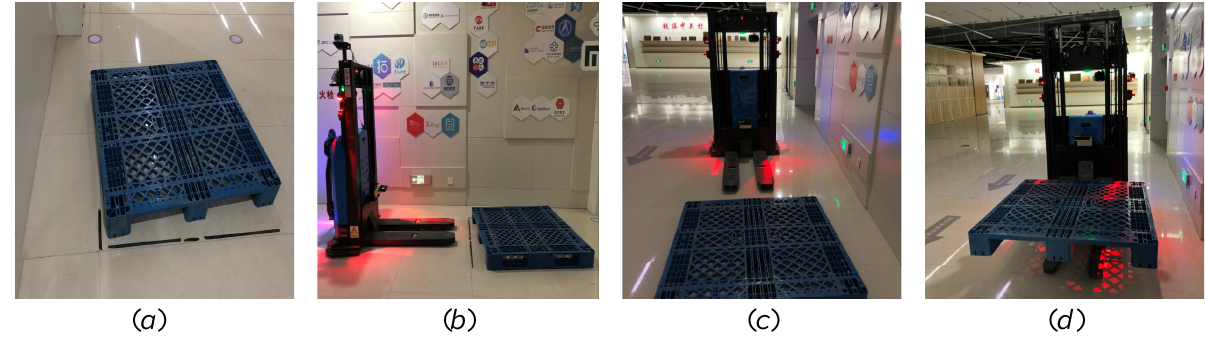
Figure 16. Difficult scene present near the pallet placement position. ( a ) Pallet. ( b ) Photo point. ( c ) Correction point. ( d ) Pallet